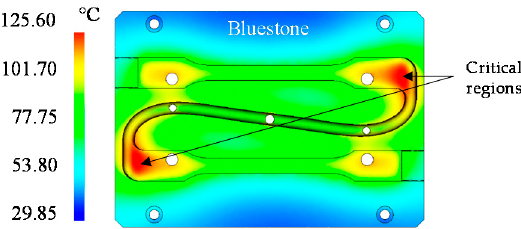
Figure 11. Moldflow simulation results of the average temperature for tensile specimen-tools out of Bluestone at 30 °C coolant temperature.